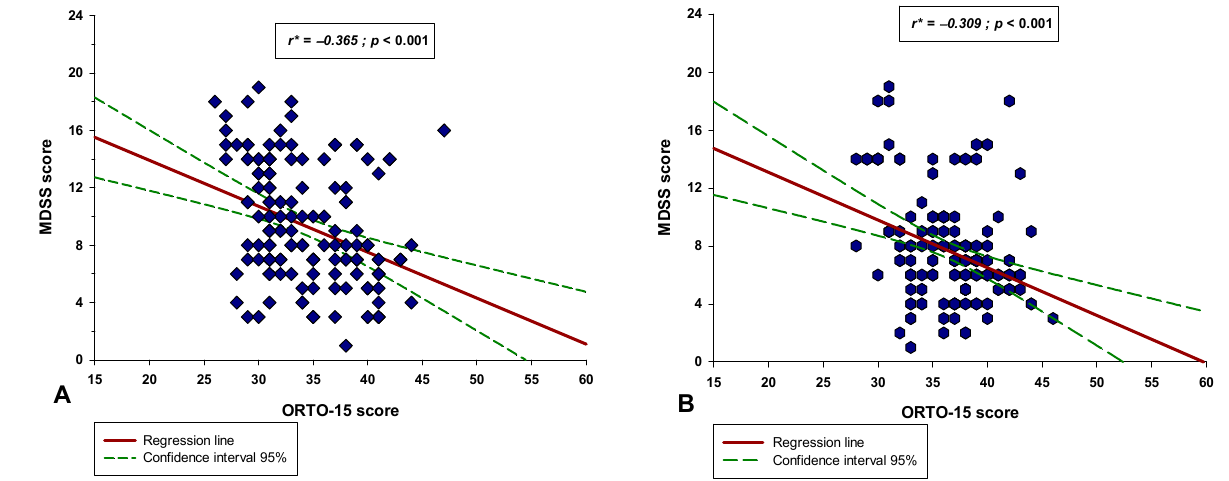
Figure 6. Correlation between the MDSS score and the ORTO-15 score in the ( A ) professional athlete group ( N = 150) and in the ( B ) recreational athlete group ( N = 150). * Spearman’s correlation coefficient.